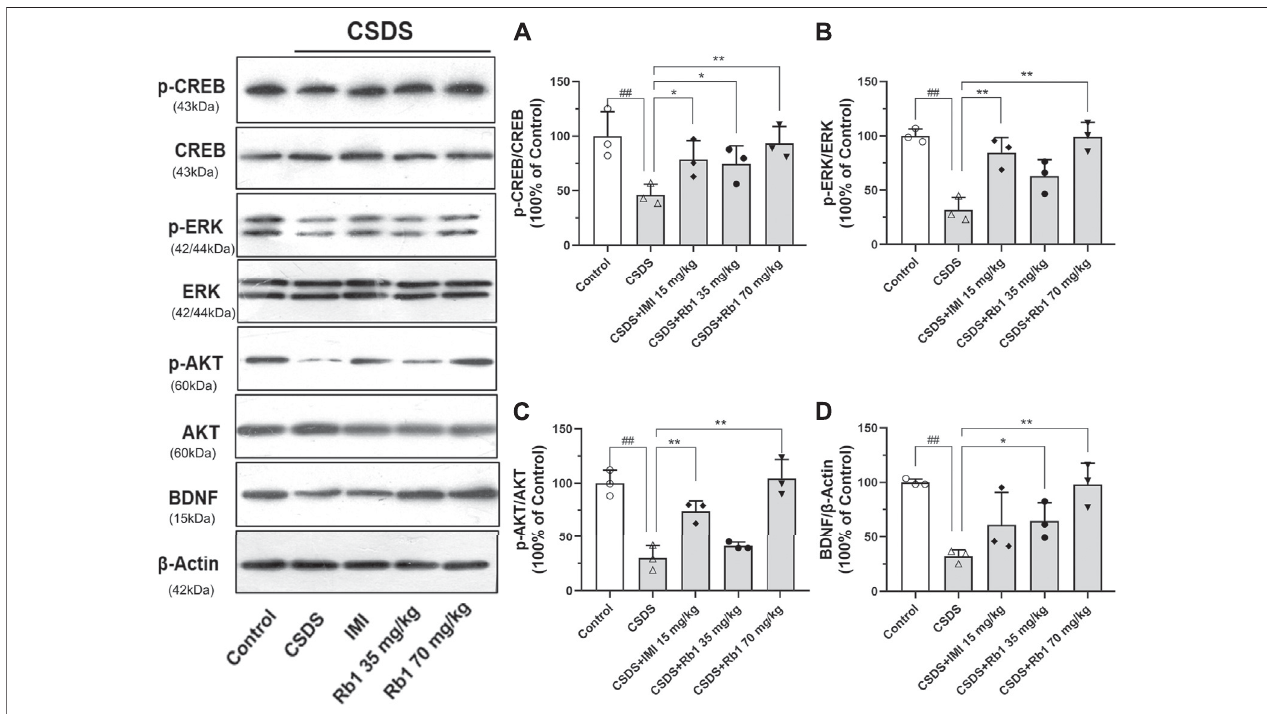
FIGURE4| In fl uenceofRb1treatmentontheexpressionoftheBDNFsignalpathwayinthehippocampusofmiceexposedtoCSDS. (A) pCREB/CREB, (B) pERK/ ERK, (C) pAKT/AKT,and (D) BDNFproteinlevels.N (cid:2) 3pergroup,theresultsareindicatedasthemean ± S.E.M. ## p < 0.01,vs.thecontrolgroup;* p < 0.05,** p < 0.01, vs. the group exposed to CSDS, by one-way ANOVA